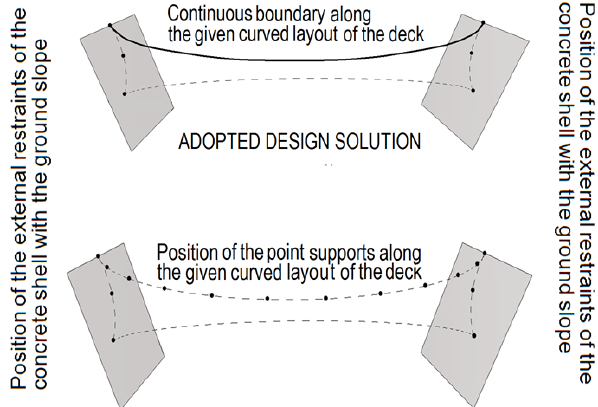
Figure 11: Assignment of the boundary conditions for the shell of a curved shell-supported bridge: (a) with the deck continuously supported by the shell top edge; (b) with the deck point-supported along the shell top edge